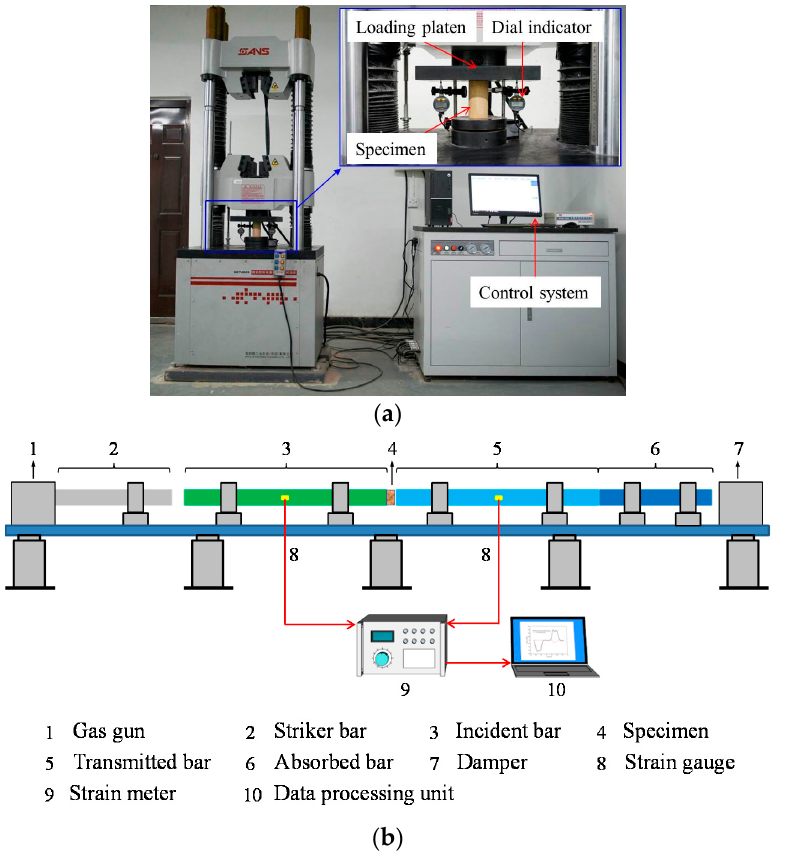
Figure 2. Experimental devices. ( a ) Uniaxial compressive testing machine. ( b ) Schematic diagram of SHPB apparatus.